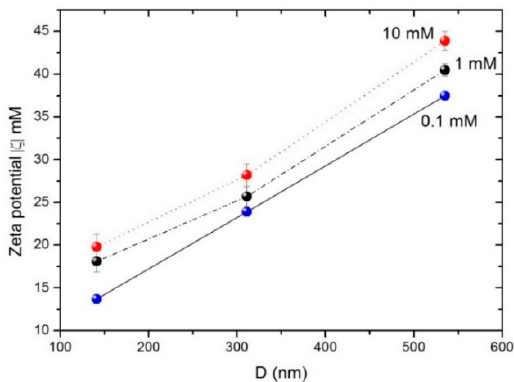
Figure 7. The zeta potential as a function of particle diameter with AOT concentration from 0.1 to 10 mM and a PS particle concentration of 0.01%.